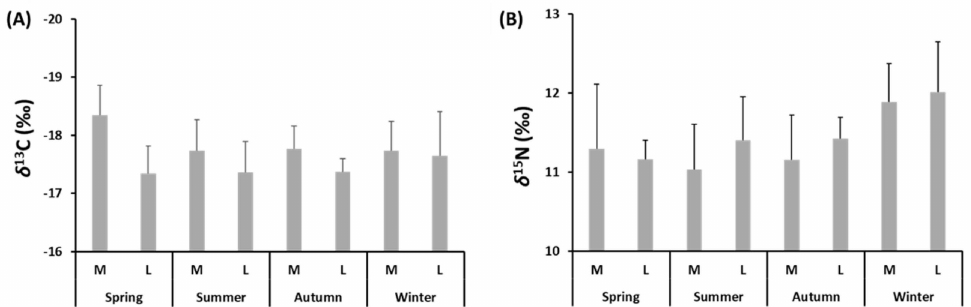
Figure 5. Values of ( A ) δ 13 C (‰) and ( B ) δ 15 N (‰) of medium (M)- and large (L)-size specimens of S. solea captured from January to December 2019 in the Central Adriatic Sea for a study of their diet. No correlation was found between the δ 13 C values and TL ( p > 0.05) or the δ 15 N values and TL ( p > 0.05). Considering the lack of a correlation between isotopic values and